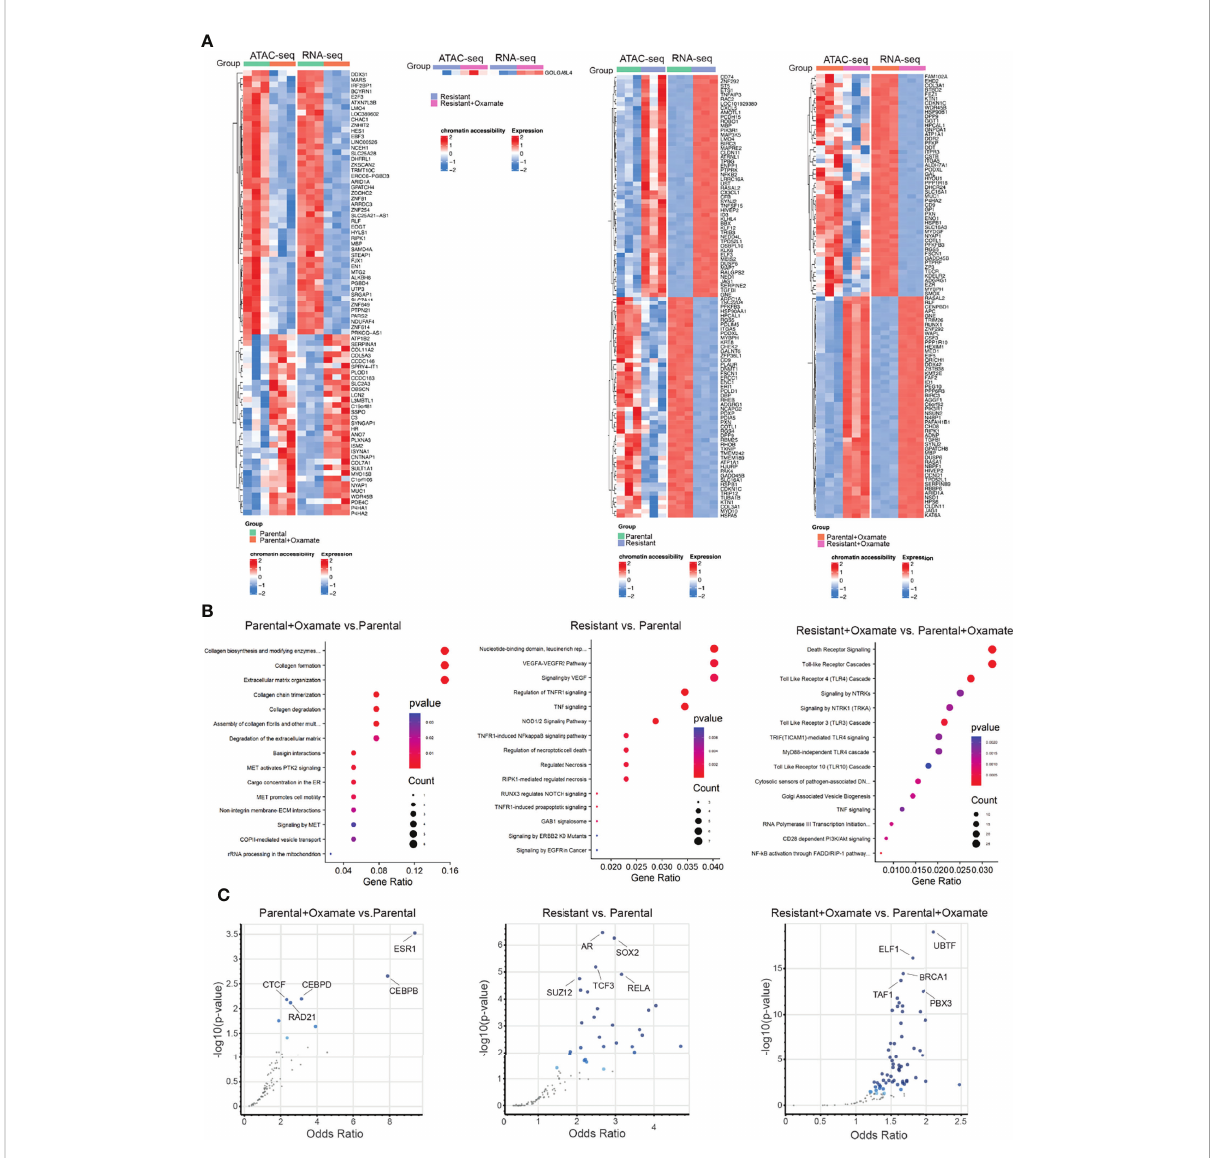
FIGURE 3 RNA-seq and ATAC-seq integrative analysis reveals genes that display coherence between changes in chromatin accessibility and mRNA expression levels. (A) Heatmap for the top 100 (50 upregulated or with increased chromatin accessibility and 50 downregulated or with reduced chromatin accessibility) genes showing similar patterns in both the ATAC-seq and RNA-seq analyses. (B) Reactome Pathway Analysis showing enriched biological pathways for genes that display coherence between changes in chromatin accessibility and mRNA expression levels. (C) Enrichr analysis using ENCODE and ChEA for identifying potential regulatory transcription factors for differentially regulated metabolic genes identi fi ed in the indicated